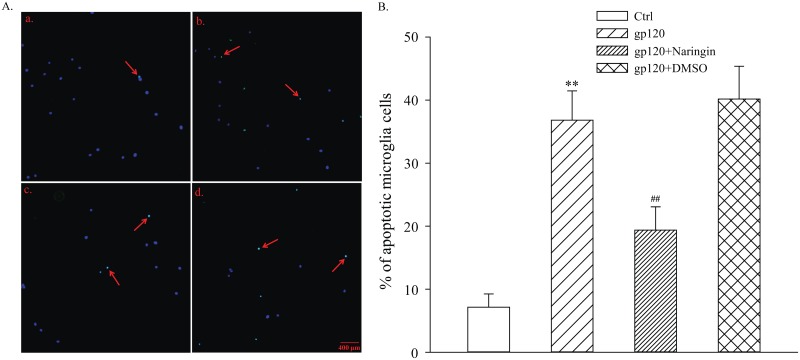
Primary cultured microglia apoptosis detected by TUNEL.A, Typical fluorescence image of apoptotic microglia in each group; blue signal indicates nuclear staining with DAPI; green signal represents TUNEL staining of fragmented DNA with FITC; arrows indicate apoptotic microglial cells; a, Ctrl group; b, gp120 group; c, gp120+naringin group; d, gp120+DMSO group. B, The percentage of apoptotic microglial cells in each group; **P < 0.01, versus Ctrl group; ##P < 0.01, versus gp120 group; n = 3.